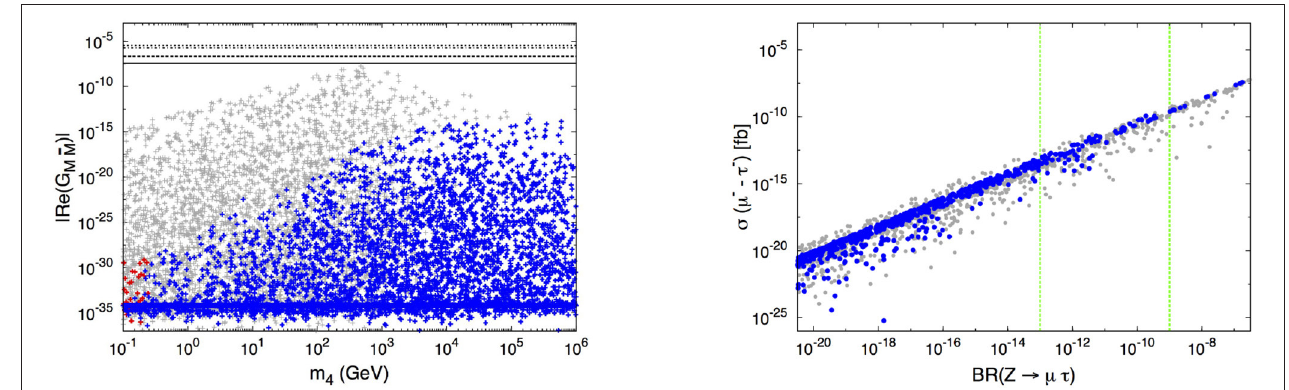
G MM ) for Mu - Mu conversion as a function of m 4 (within the framework of a simple “3+1 model”). Dark blue Re (cid:17)(cid:12) (cid:12) (cid:16) (cid:12) (cid:12) (cid:12) (cid:12) τ ) vs. BR( Z τµ ) in the “3+1 model”; blue (gray) points denote allowed (excluded) → →